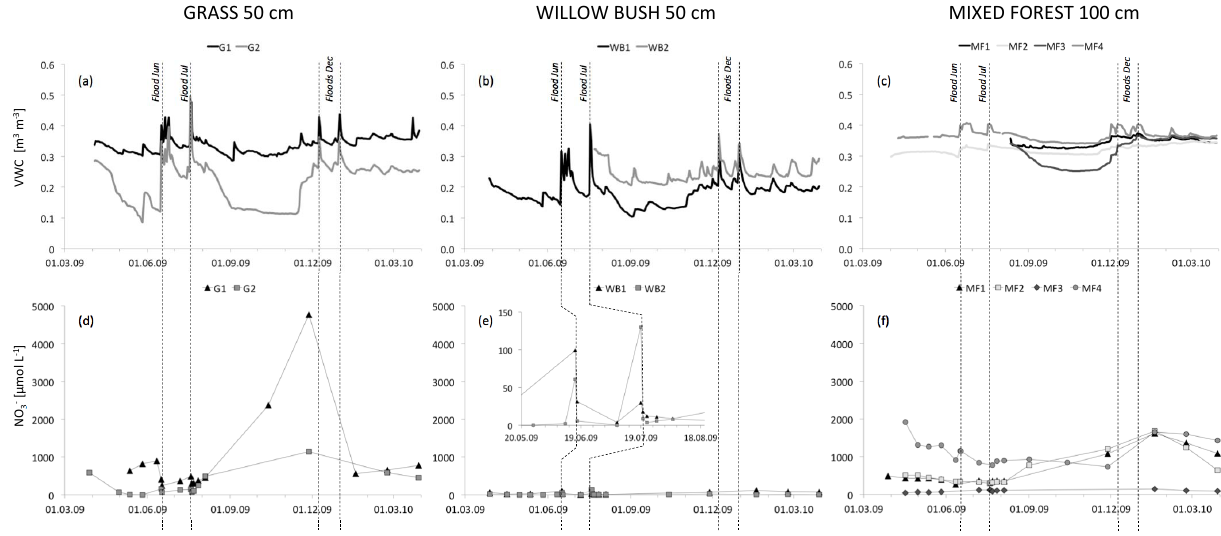
Fig. 5. VWCs (a–c) and nitrate concentrations (d–f) at 50cm depth in GRASS and WILLOW BUSH and 100cm in MIXED FOREST.